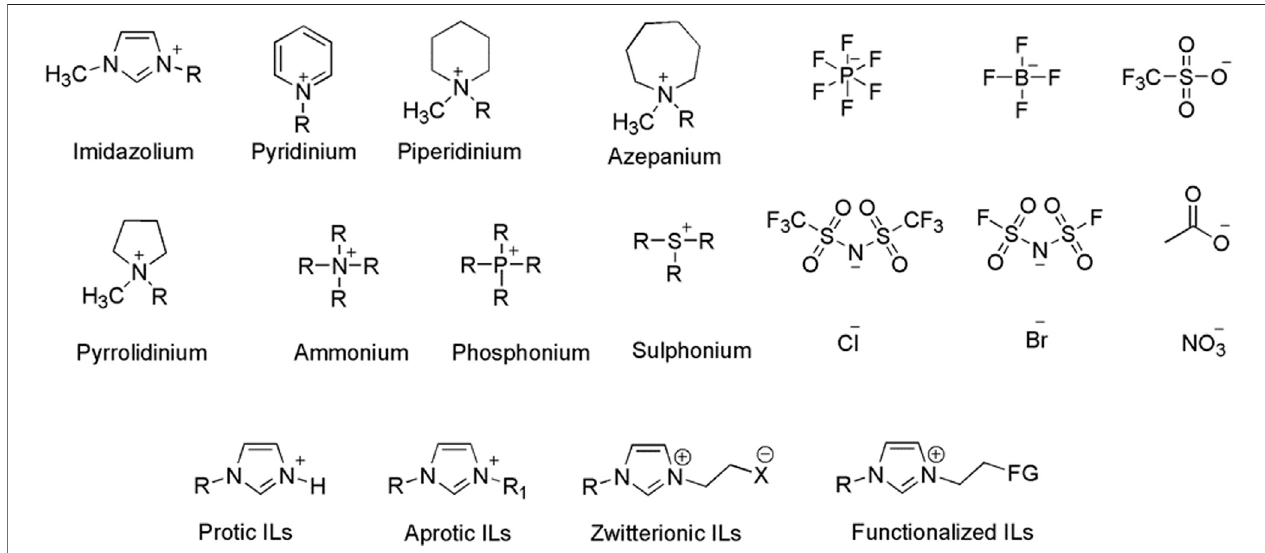
FIGURE 1 | Commonly used cations and anions in ILs and the classi fi cation of ILs (H- proton, R 1 -Alkyl chain, X- electronegative atom, FG-Functional group).